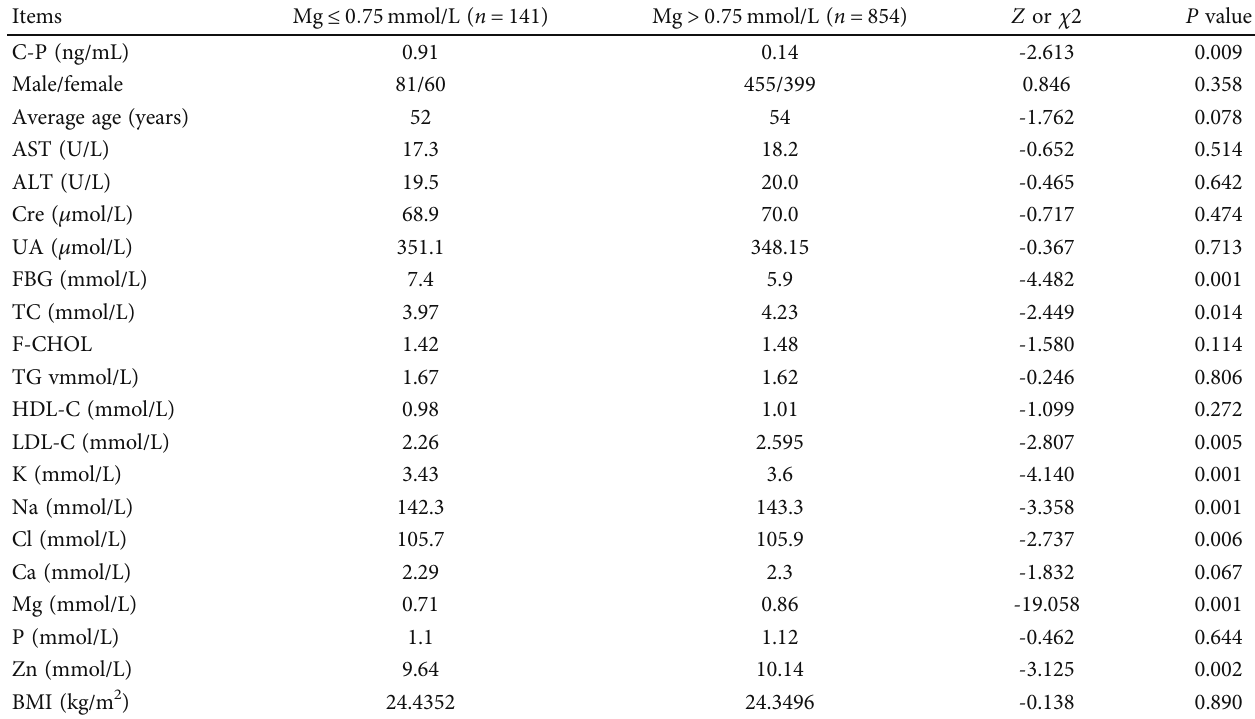
Table 9: Comparison of clinical data of patients in the Mg ≤ 0 : 75 mmol/L and Mg > 0 : 75mmol/L